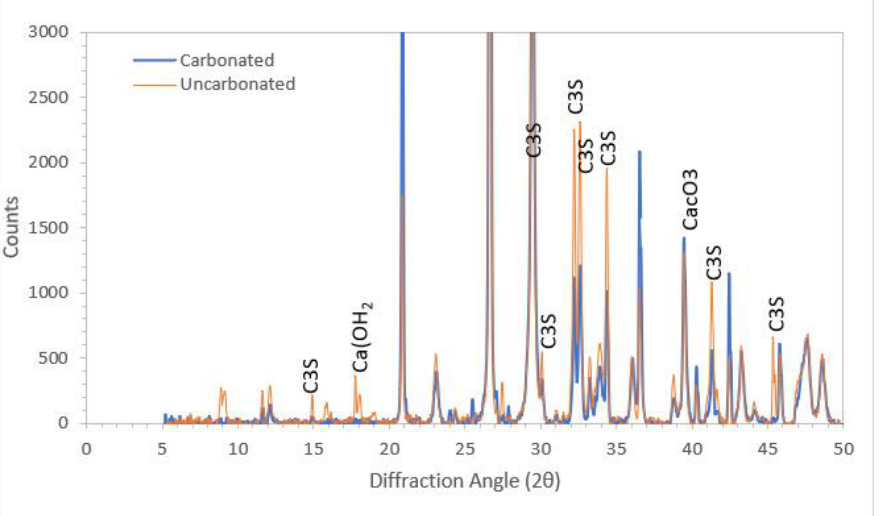
Figure 13. XRD analysis showing tricalcium silicate (C 3 S), Ca(OH) 2 and CaCO 3 patterns in carbonated and uncarbonated mortar samples. Carbonation took place at 5 bar for 24 h [28].